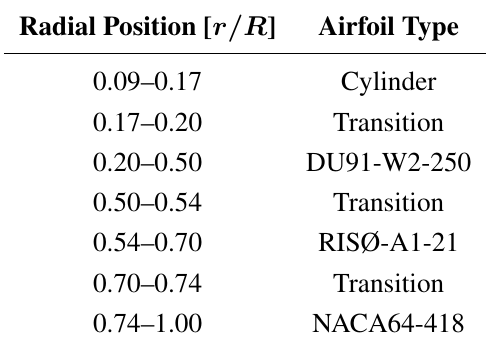
Table 1. Airfoil type distribution along the span of the MEXICO (Model Experiments in Controlled Conditions)